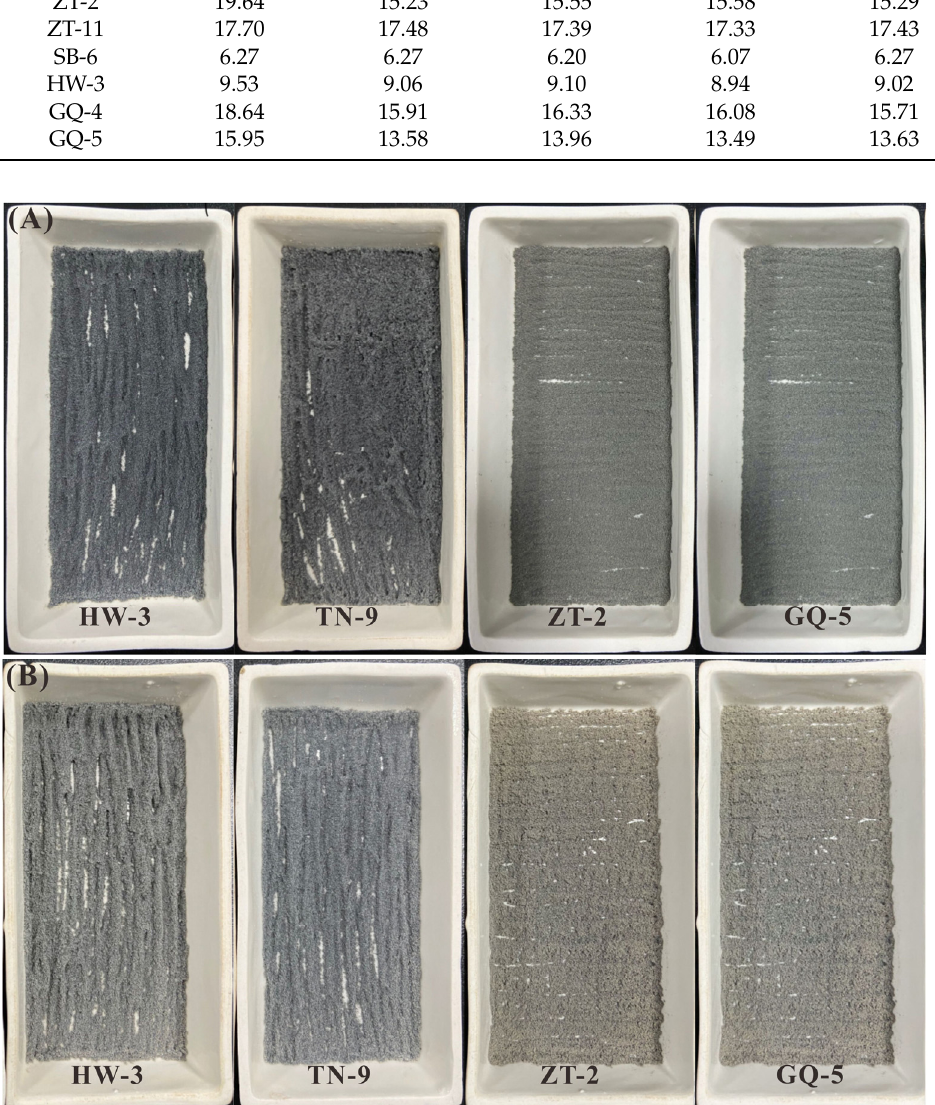
Figure 4. The color changes of coal surface in samples HW-3, TN-9, ZT-2 and GQ-5 after the first ashing at the two ashers. ( A ) by IoN 40-B program; ( B ) by K1050X-E